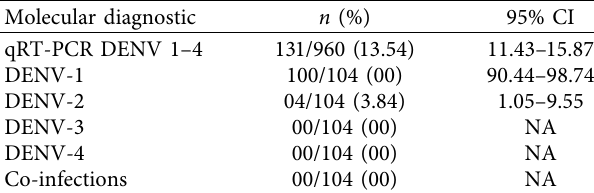
Table 2: Circulating serotypes of DENV among infected